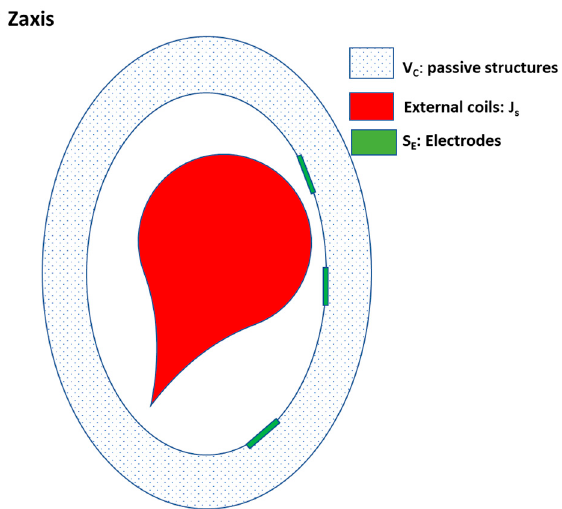
Figure 1. A schematic figure reporting the meaning of the symbols used in Equation (5).